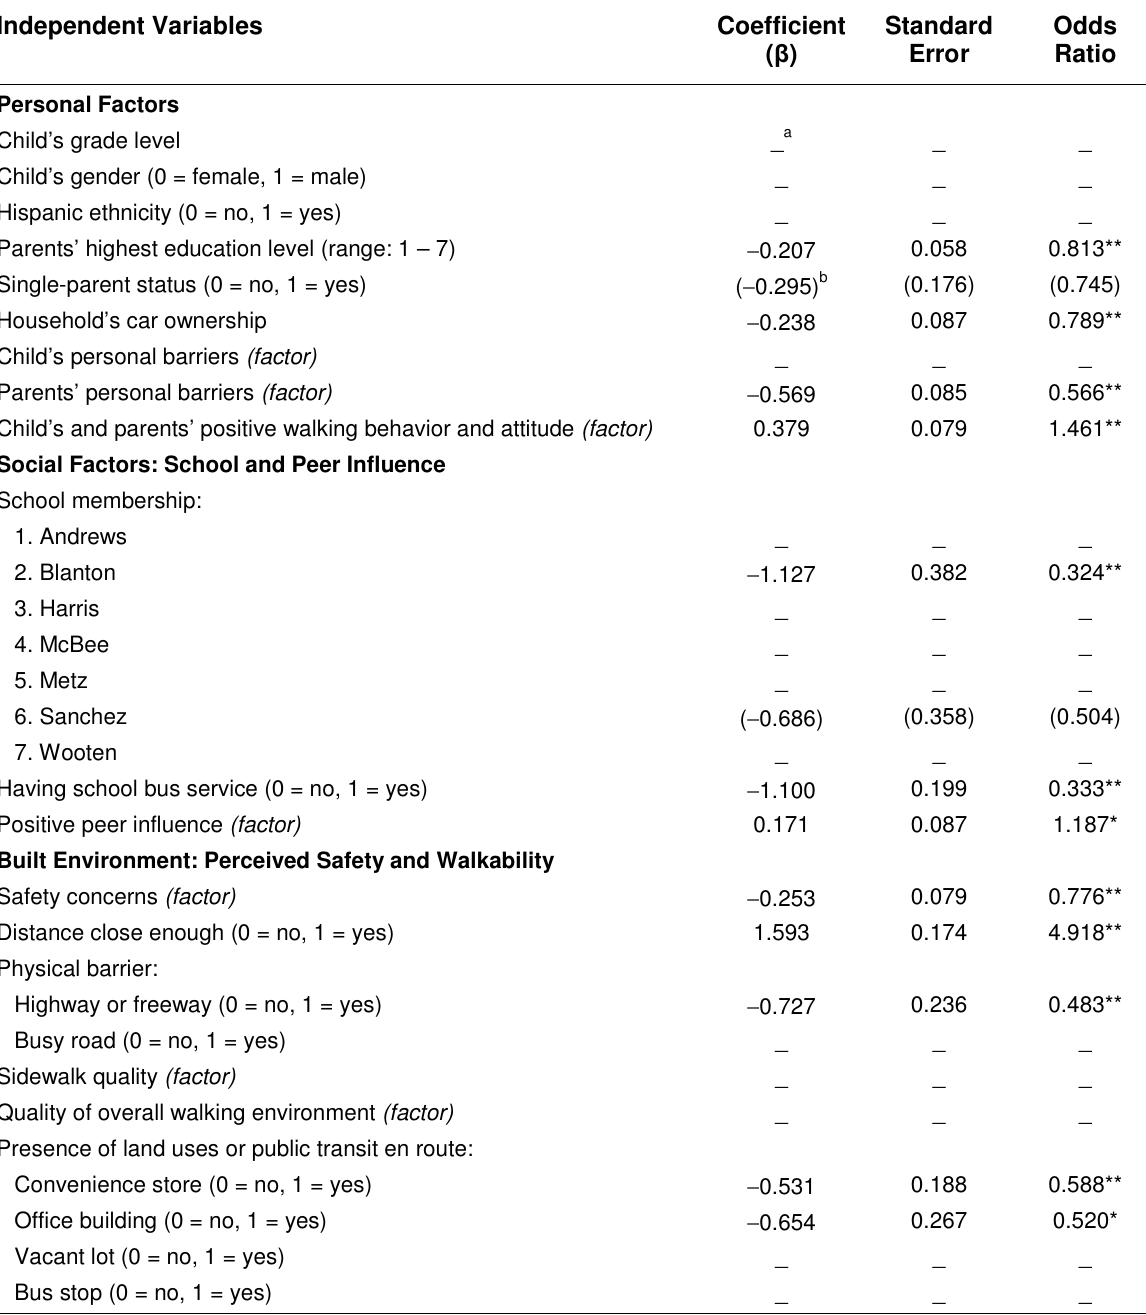
Binary Logistic Regression for the Pooled Sample from Eight Schools (n = 1180) Independent Variables